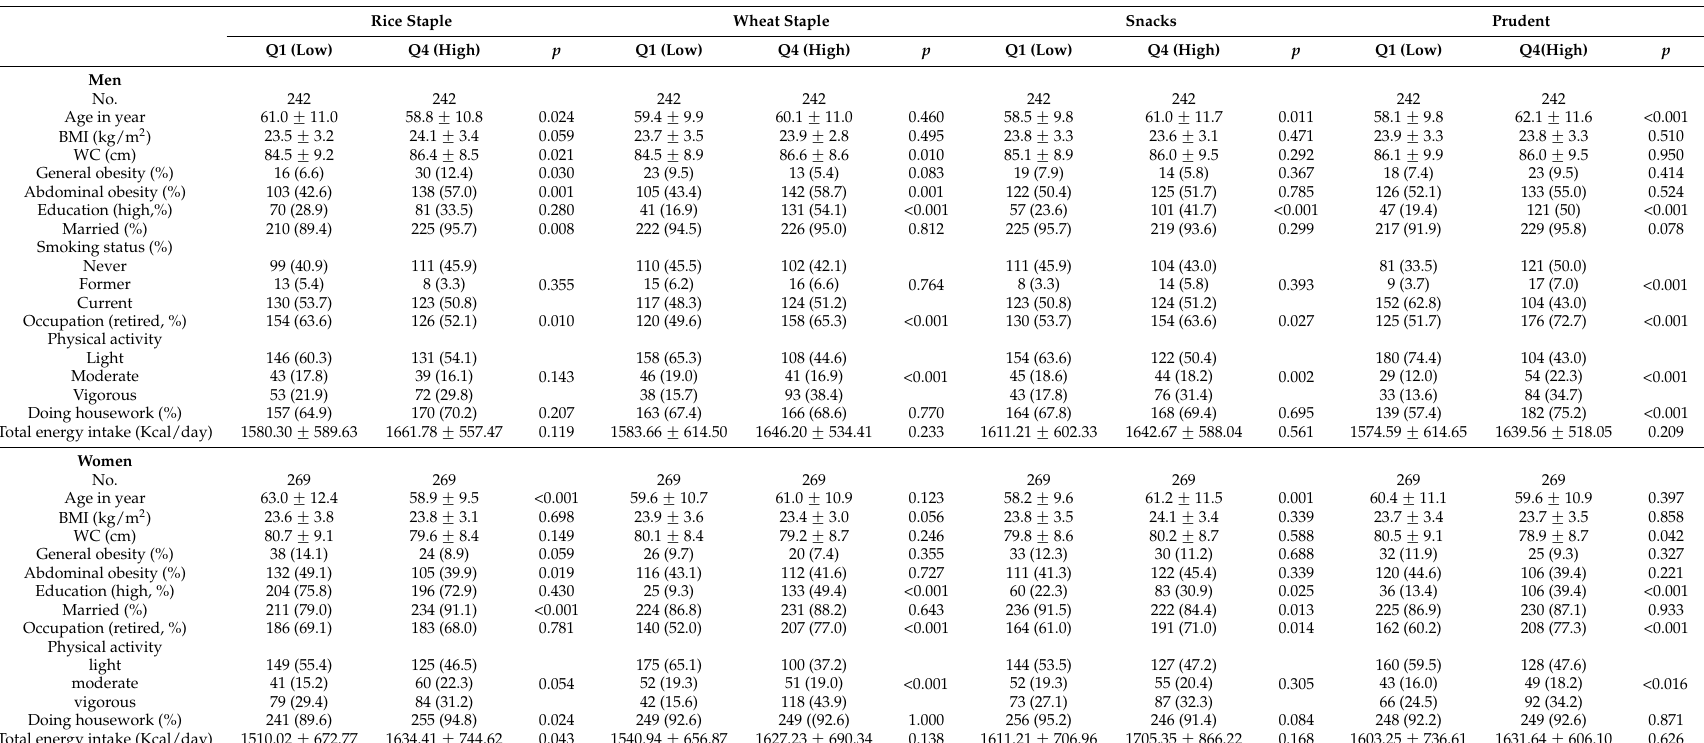
Table 4. Characteristics of participants by quartiles (Q) of dietary pattern